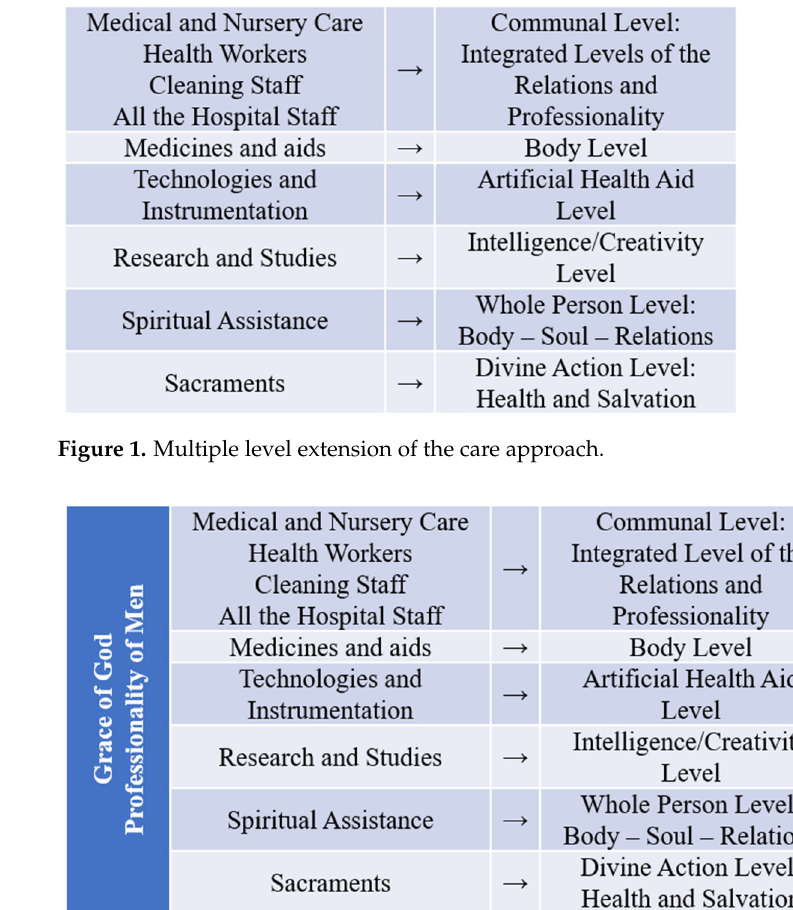
Figure 2. Multiple level extension of the care approach enhanced by Grace of God.